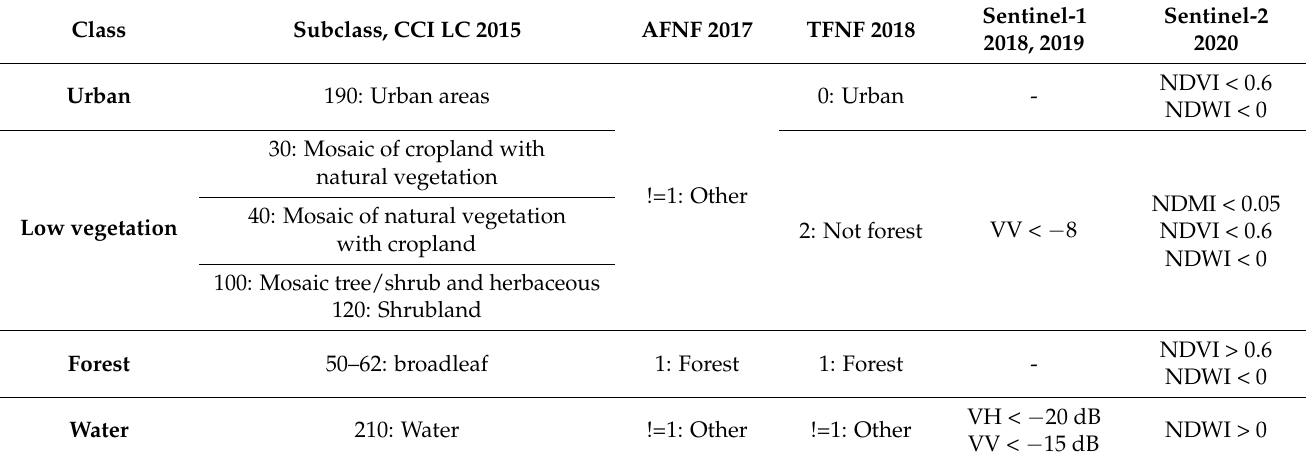
Table 2. Tropical site classification scheme together with the ruleset employed to determine the membership based on the preexisting datasets. The subclasses are based on CCI LC. GUF had to be 255 (urban) for the homonymous class, and 0 (other) for the rest of classes. “!=” denotes the NOT